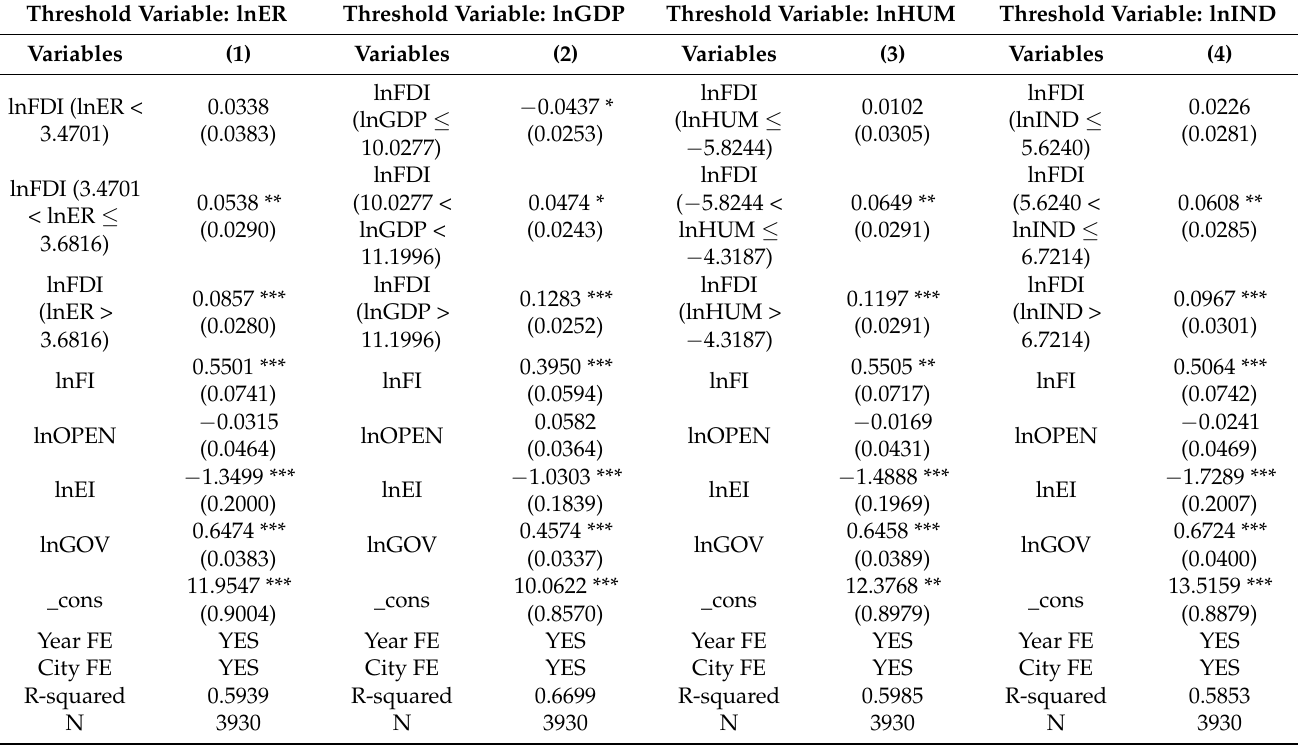
Table 4. Threshold model